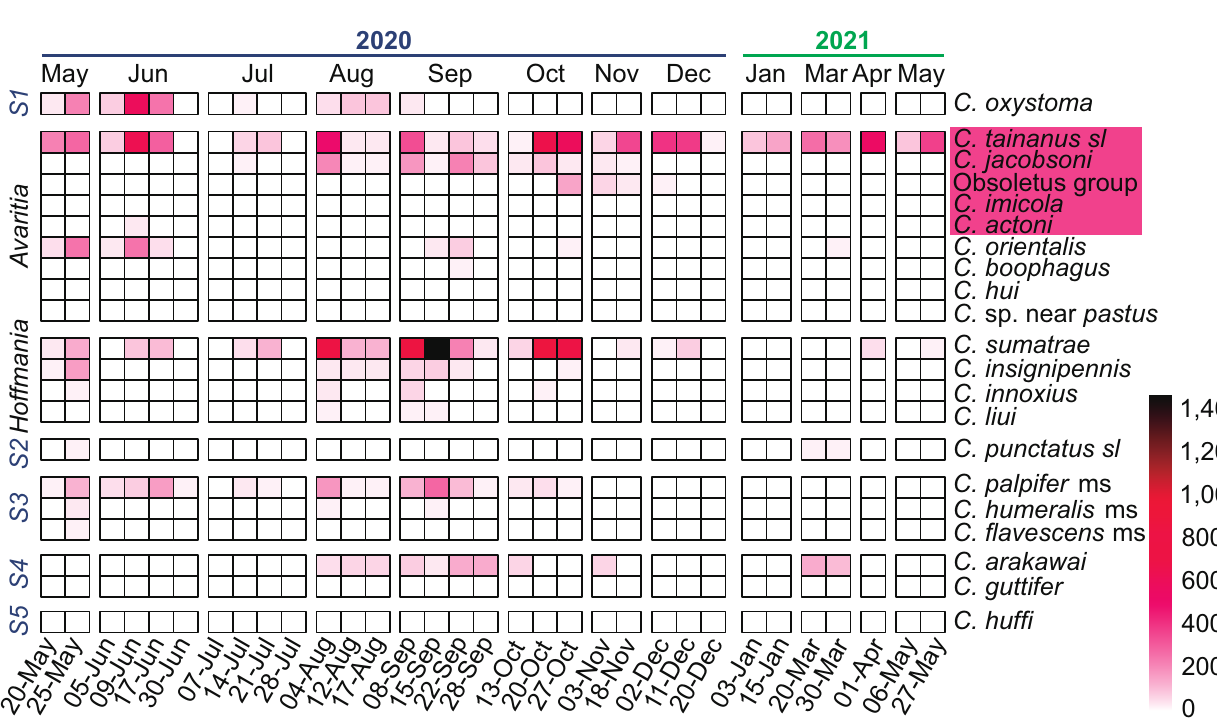
Figure 3. Heatmap of Culicoides abundance in collections from Wulong, Shizong County, Yunnan Province, China between May 20, 2020 and May 27, 2021. Known or suspected vectors of BTV are highlighted in red. S1 , S2 , S3 , S4 and S5 represent the Culicoides subgenera Remmia , Culicoides , Trithecoides , Meijerehelea , and the Clavipalpis group,